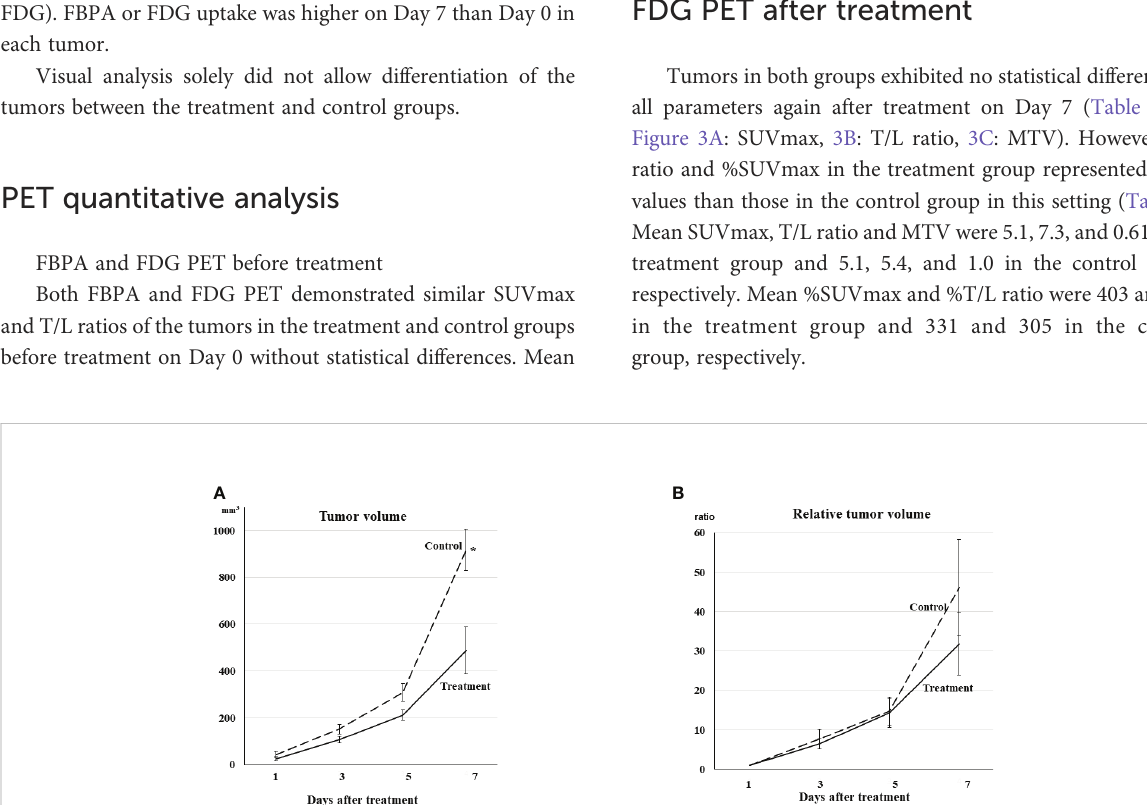
Figure 3A: SUVmax, 3B: T/L ratio, 3C: MTV). However, T/L ratio and %SUVmax in the treatment group represented larger values than those in the control group in this setting (Table 1).